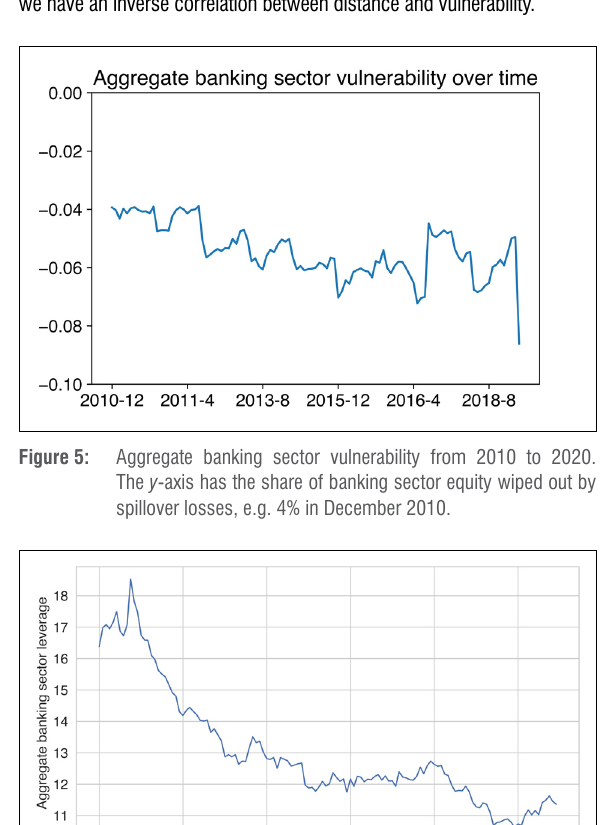
The scatter plot in Figure 7 shows the strong negative correlation between portfolio distance as measured by the average Euclidean distance between similar the banks, the lower the distance between their portfolios. Hence, we have an inverse correlation between distance and vulnerability.